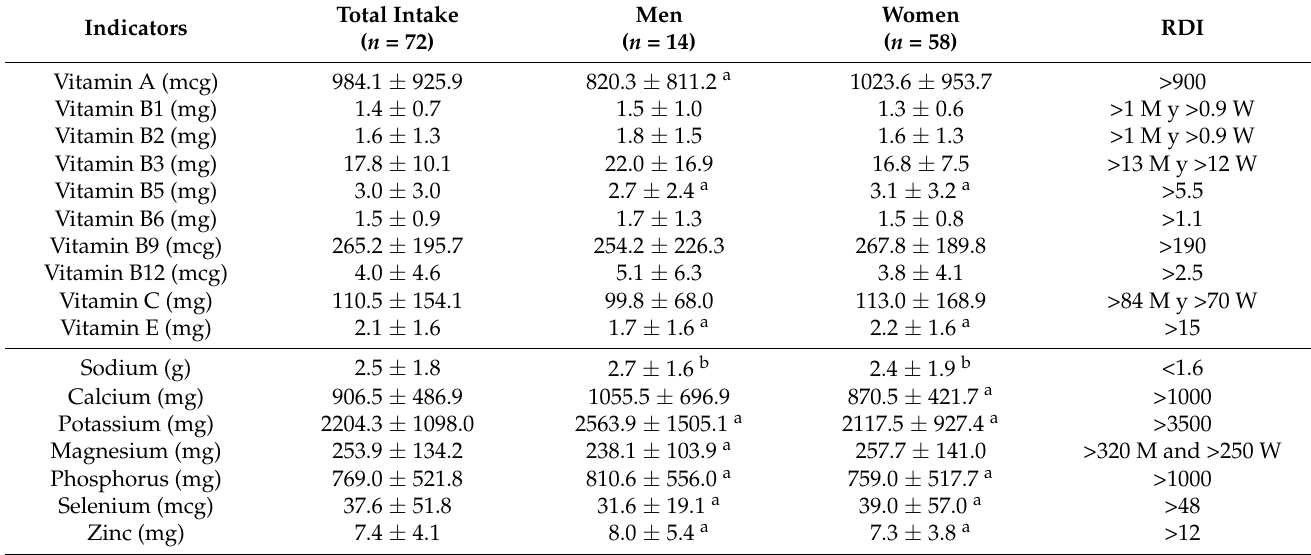
Table 1. Intake of micronutrients according to the recommended daily intake (RDI).